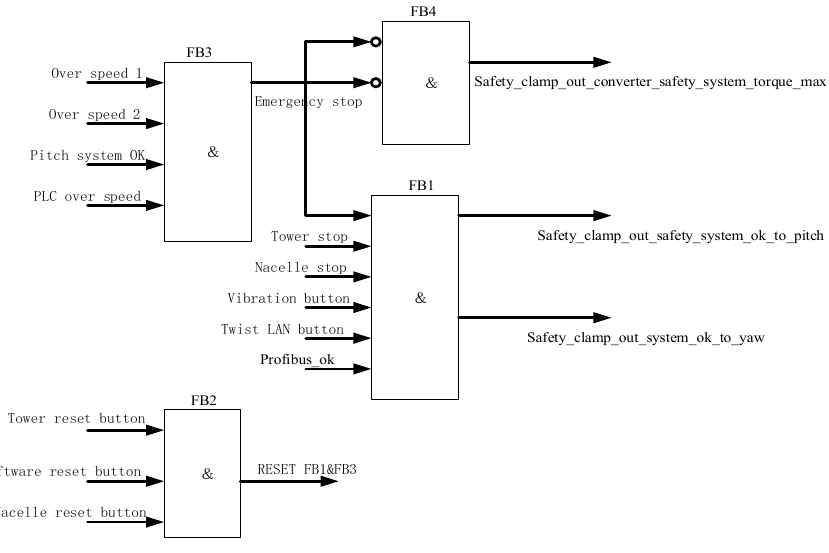
Figure 13. Logic structure of the WT safety system.